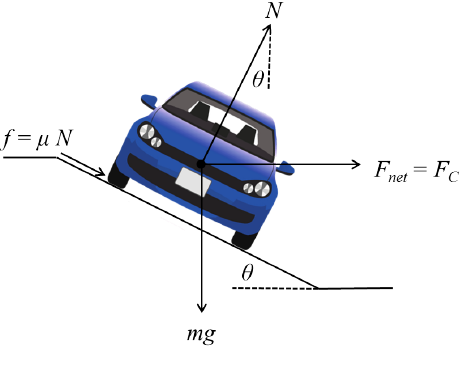
Figure 7. Centripetal force